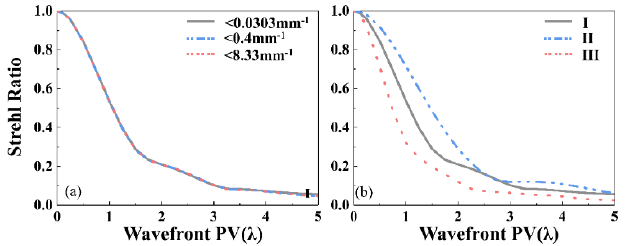
Figure 8. Variations in Strehl ratio with PV value of the original wavefront. ( a ) The SR of wavefront I with different spatial-frequency types. ( b ) The SRs of the low frequency of wavefront I, II, and III.